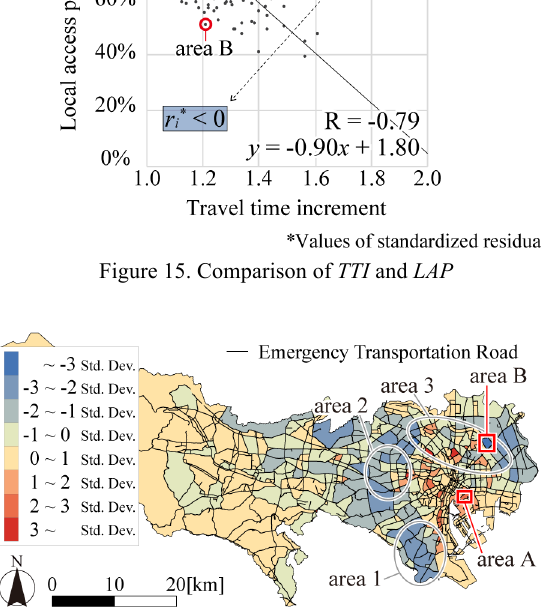
Figure 16. Spatial distribution of standardized residuals from simple liner regression model of